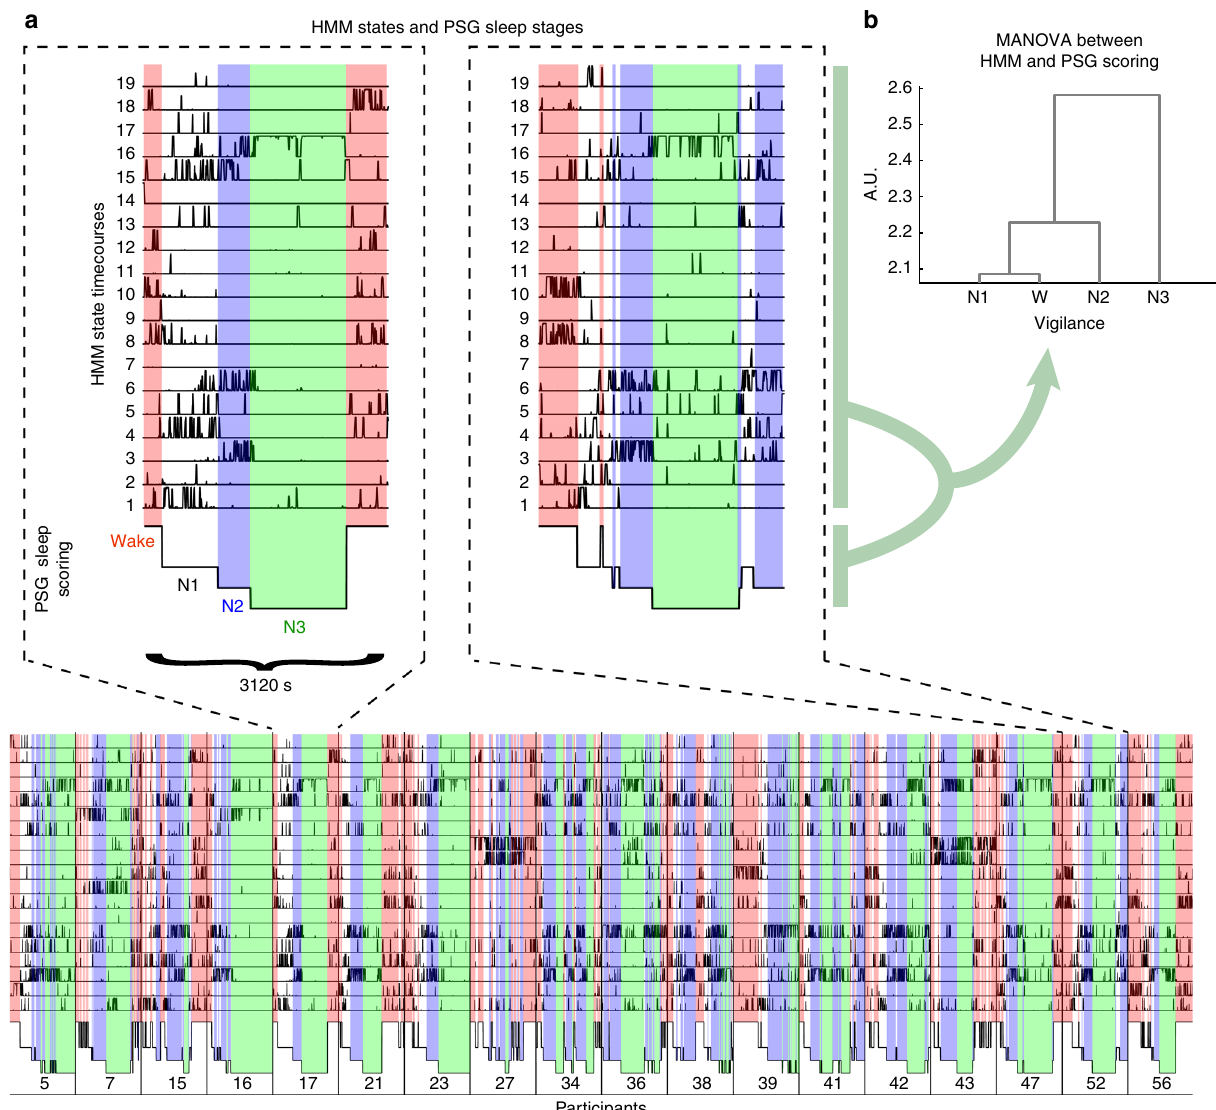
56N2N1Wake12345678910111213141516171819 Fig. 2 State timecourses of whole-brain network states and their association to polysomnography. a The fi gure shows the 19 HMM state timecourses describing each state ’ s probability of being active at each sample point of the fMRI sessions in the 18 participants that reached all four PSG stages. Below the HMM state timecourses are shown the independently obtained PSG sleep scoring (based on the simultaneously acquired EEG). The coloured overlay shows periods scored as wakefulness (red), N1 (white), N2 (blue) and N3 (green). The two dashed boxes highlight the HMM state timecourses and PSG scoring of two representative participants. Note, how the majority of HMM timecourses varied with the PSG stages, in highly consistent ways across participants. A few ‘ sporadic ’ HMM states, occurring mainly in a few participants, are also visible (e.g., states 11 and 12). b Quantifying the multivariate relationship between the HMM states and the PSG scoring, through the use of MANOVA, revealed a hierarchical grouping of the HMM states, in which wakefulness and N1 sleep were separated from N2 sleep, which in turn was separated from dendrogram of Fig. 2b, with wakefulness and N1 sleep sig- ni fi cantly separated from N2 sleep, which in turn was further separated from N3 sleep.